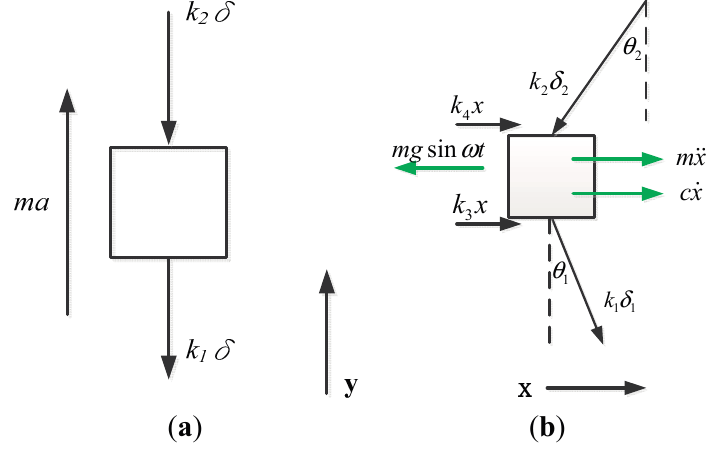
Figure 2. Kinetic body diagram. ( a ) y -axis and ( b ) x